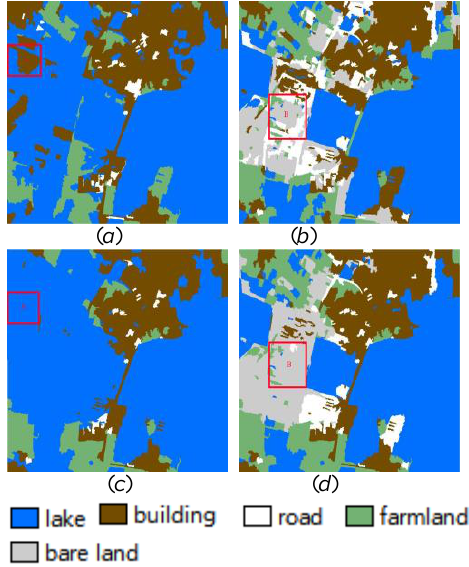
Figure 4 . Classification results: (a) classification